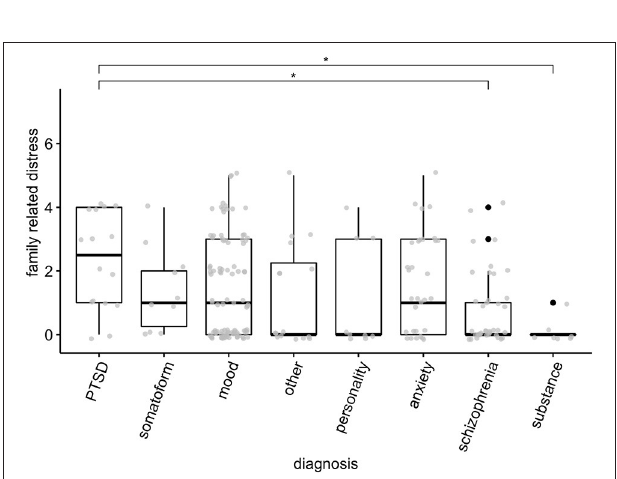
FIGURE 2 | Family related distress across different diagnoses. Boxes represent quartiles, black dots represent outliers. Gray points represent scores of individual patients. * p <